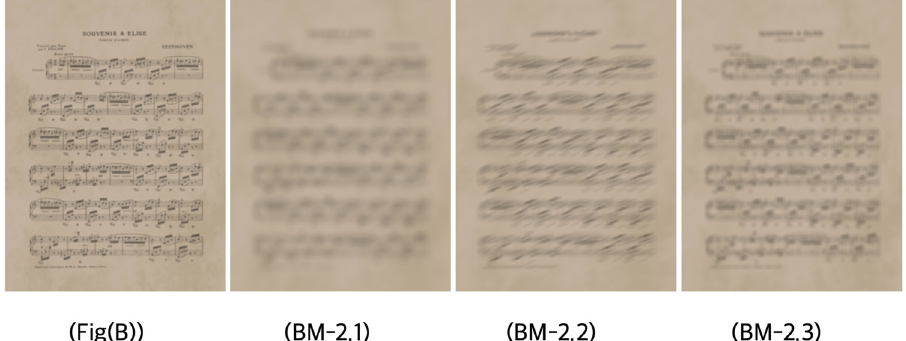
Figure 2: The original image size × 240 320 ( Fig ( A )) and the deblurred RGB image by out - of - focus blur matrices with radius 6 ( BM - 1.1 ) , Gaussian blur with standard deviation 7 of the fi lter size [ ] × 5 5 ( BM - 2.2 ) , and the deblurred image by motion blur speci fi ed with the motion length of 11 pixels and motion orientation 23 ( BM - 2.3 ) , respectively.